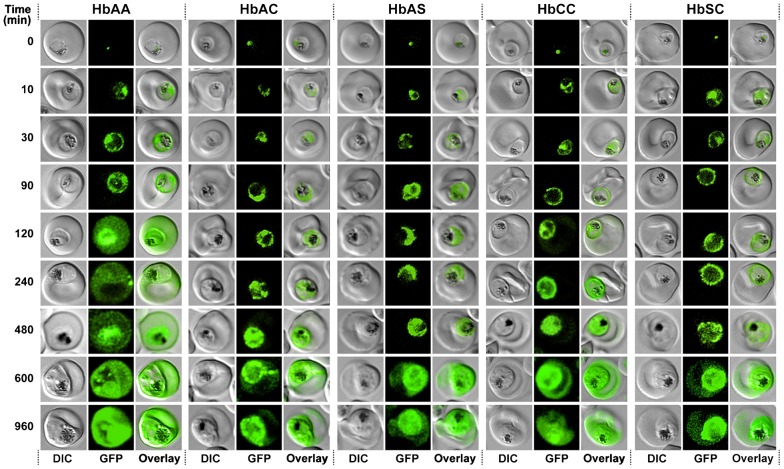
Kinetics of export of SOLCAD in various P. falciparum-infected erythrocytes.P. falciparum-infected erythrocytes were taken from culture at the time points indicated after the addition of the anti-aggregation ligand and immediately analyzed by live cell confocal fluorescence microscopy. Tightly synchronized cultures at the trophozoite-stage (18–22 h post invasion) were used. Images shown are representative examples for the export phenotypes that were used for later quantification.